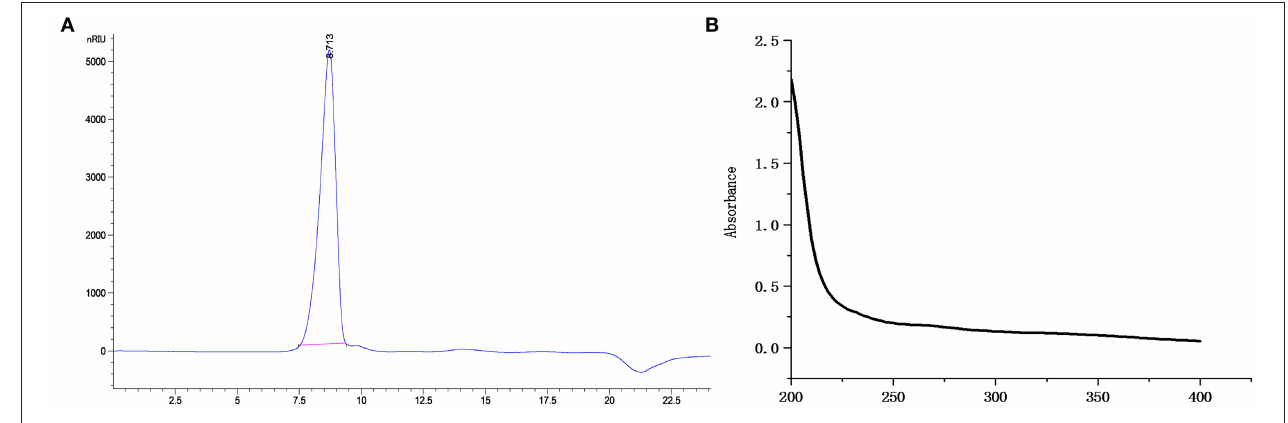
FIGURE 1 | The HPGPC chromatograms (A) and UV-vis spectra (B) of